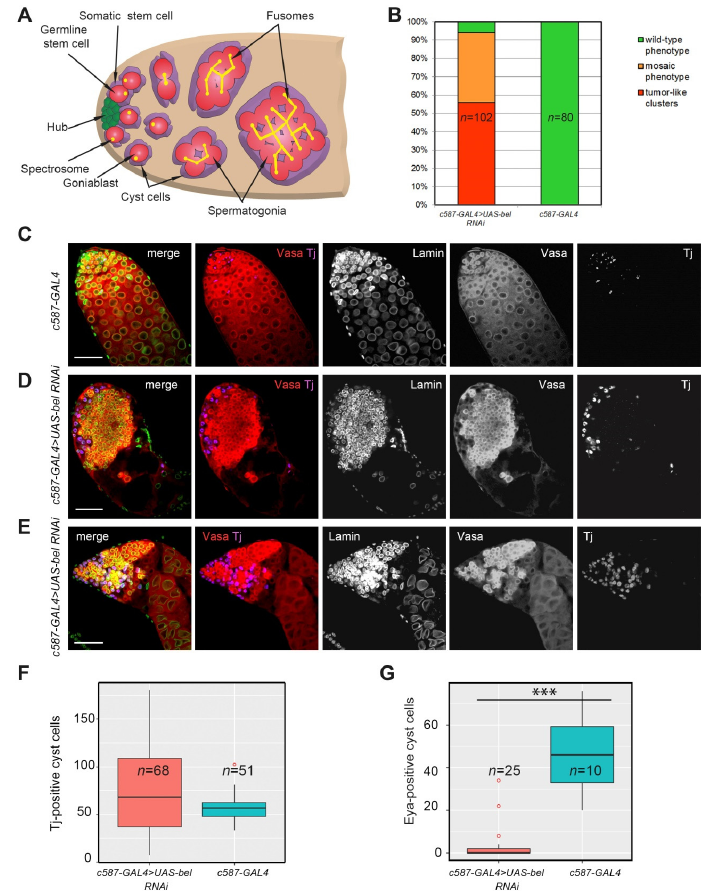
Figure 1. Phenotypic analysis of the testes of males with RNAi belKD in somatic cyst cells and the control c587-GAL4 driver line. ( A ) Scheme of the apical tip of Drosophila testis. Germline stem cells (red) are located near the hub (green) and are encapsulated by two somatic cyst stem cells (violet). A daughter of a germline stem cell (GSC), the goniablast (red), undergoes four cell divisions to generate cysts of 2–16 spermatogonia. The 16-cell cyst enters the spermatocyte growth program and meiosis (not shown). Dot-like structures in GSCs and goniablasts, spectrosomes (yellow dots), become branched fusomes in the secondary spermatogonial cells and spermatocytes. ( B ) belKD in cyst cells leads to the appearance of tumor-like germ cell clusters. The bar diagram depicts the distribution of testis phenotypes of c587-GAL4 > UAS-bel RNAi and control c587-GAL4 0–1 day-old males: wild-type (green), mosaic (orange), and strong tumor-like phenotype (red). ( C–E ) Testes of newly eclosed males with belKD in cyst cells and of control males were immunofluorescently stained with anti-Vasa (red), anti-Lamin (green), and anti-Tra ffi c jam (Tj, violet) antibodies. Lamin staining indicates nuclear envelope positions. Internal confocal slices of the immunostained whole-mount fixed testis preparations are shown. The apical tips of the testes are oriented leftward on all panels here and after. Scale bars are 50 µ m. ( C ) Testes of the control c587-GAL4 line represented the wild-type phenotype. ( D ) More than one half of the analyzed c587-GAL4 > UAS-bel RNAi testes (55.9%) contained tumor-like clusters of early germ cells with Tj-stained somatic cyst cells found to be segregated from germ cells. ( E ) Another fraction of c587-GAL4 > UAS-bel RNAi testes represented a mosaic phenotype and contained cysts of spermatogonia and spermatocytes along with tumor-like clusters. ( F ) Tj-stained cyst cells are insignificantly increased in number in the testes upon cell-autonomous belKD in cyst cells. The boxplot diagram shows the number of Tj-positive early cyst cells per testis in c587-GAL4 > UAS-bel RNAi and control c587-GAL4 testes. Statistical analysis was performed by Wilcoxon / Mann–Whitney two-sided test, p = 0.073. ( G) Eya-stained cyst cells are lost upon belKD in the cyst cells. The boxplot diagram shows the number of Eya-positive late cyst cells per testis in c587-GAL4 > UAS-bel RNAi and control c587-GAL4 testes. Statistical significance (***) was determined by Wilcoxon / Mann–Whitney two-sided test, p = 4.528 ·× 10 − 6 . The bold lines on the boxes ( F, G ) mean median